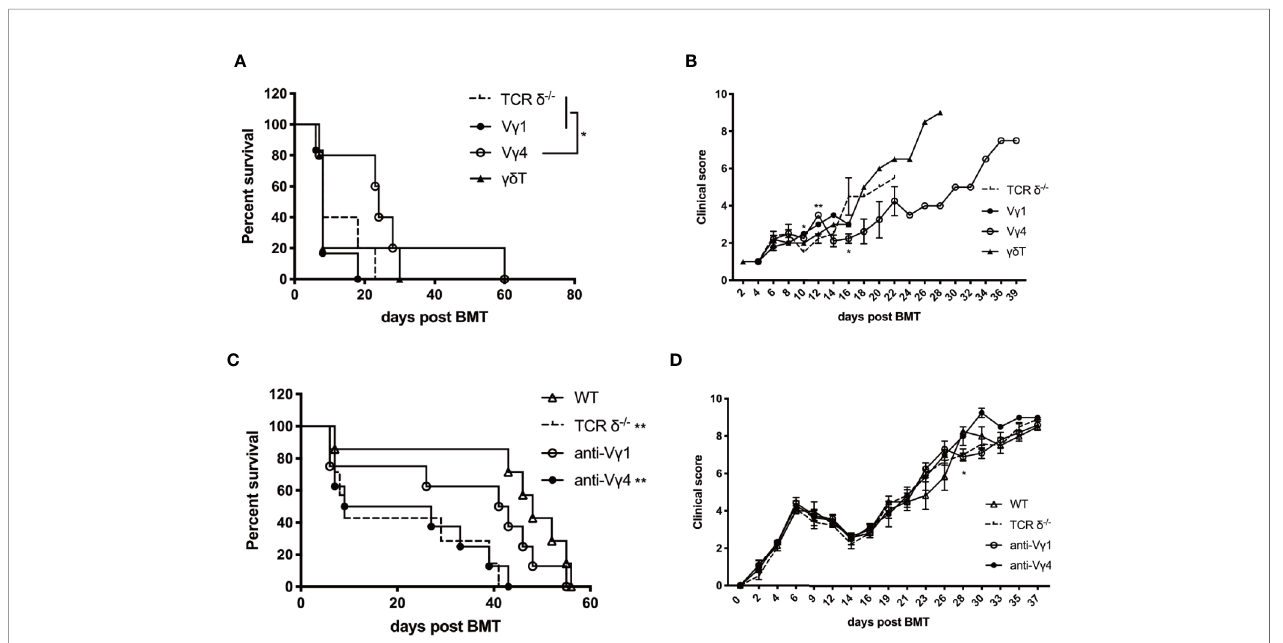
FIGURE 6 | Donor V g 4 gd T cells are the main cell subset mitigating aGVHD. The survival (A) and clinical scores (B) of aGVHD recipients that received adoptively transferred V g 1, V g 4, or total gd T cells. BALB/c mice were lethally irradiated and received splenocytes (5 × 10 6 cells/mouse, iv .) plus BMCs (1 × 10 7 cells/mouse, iv. ) from TCR d ‐ /- mice. V g 1, V g 4, or total gd T cells (1 × 10 7 cells/mouse, iv. ) were infused into recipients on day 0. The survival (C) and clinical score (D) of aGVHD recipients that were depleted of V g 1 or V g 4 cells. BALB/c mice were lethally irradiated and received splenocytes (4 × 10 6 cells/mouse, iv.) plus BMCs (1 × 10 7 cells/ mouse, iv. ) from WT donors. Anti-V g 1 or anti-V g 4 antibody (100 µg/200 µl/mouse) was administered into the recipients once a week for 3 weeks intraperitoneally. IgG (100 µg/200 µl/mouse, ip. ) was injected as controls. All data are representative of at least 3 independent experiments with n ≥ 5 mice per group. All summary graphs display mean ± SEM. Signi fi cance was determined by log-rank (Mantel-Cox) survival test (A, C) and one-way ANOVA (B, D) . * p < 0.05, ** p <